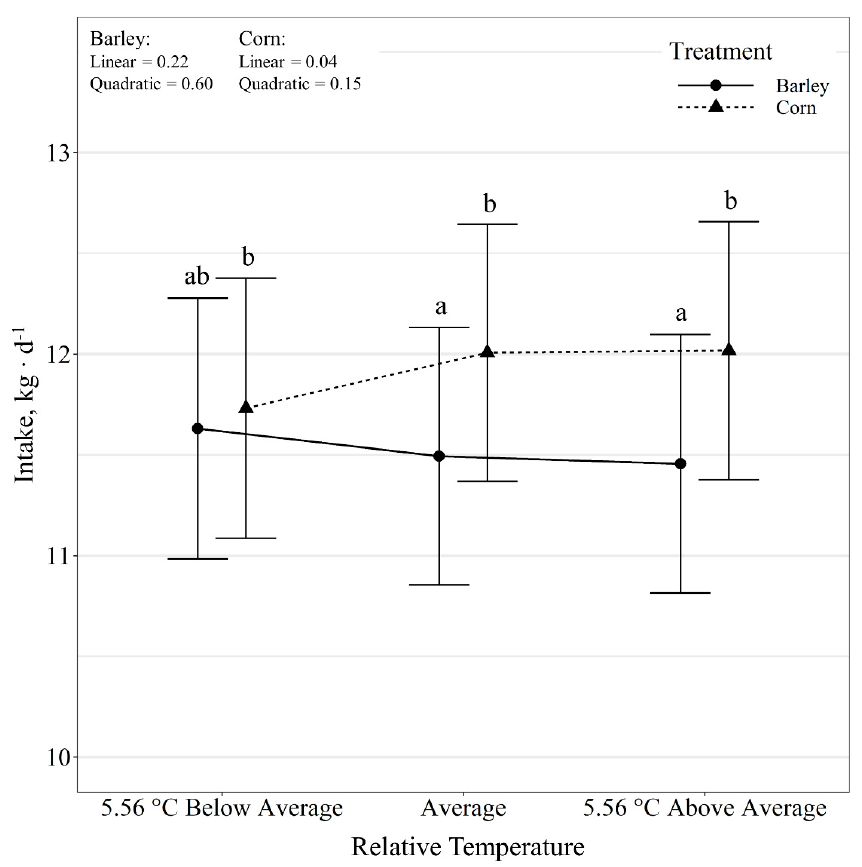
Figure 1. Influence of relative temperature change × diet ( p = 0.05) on average daily intake (expressed as kg d − 1 ) by beef steers consuming either barley or corn-based feedlot diets at the Northern Agricultural Research Center, Havre, MT, USA. Data points without a common letter differ ( p < 0.05).